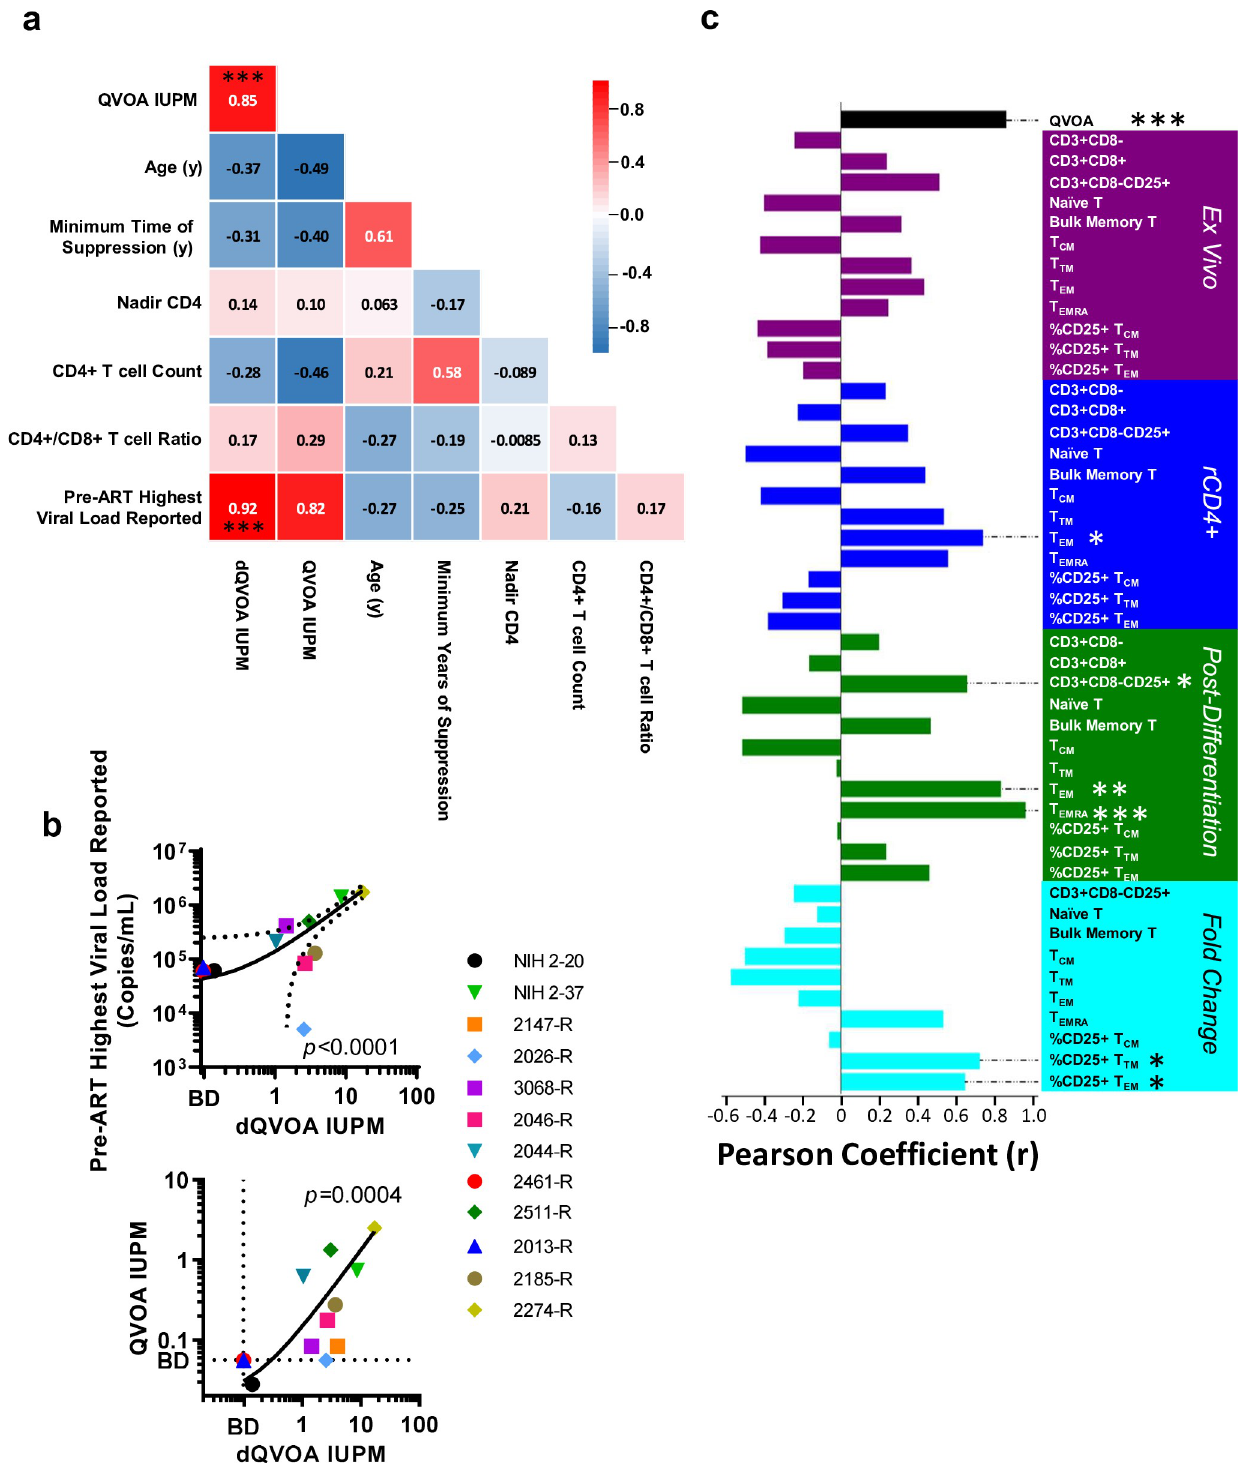
Fig 3. Reservoir measurements derived from dQVOA directly correlate with QVOA, pre-ART highest viral load reported, and effector memory T cells. a, The cross-correlation matrix (Pearson r value) of clinical measurements from linear regression. Analysis includes all available data from participants across the NIH and RAVEN cohort. ��� denotes p < 0.001. b, XY Graphical representation of correlations found to be significant in panel a . c , Correlation with dQVOA IUPM from linear regression (Pearson r value) for each individual measurement. Analysis includes available data from participants in the RAVEN cohort. � denotes p < 0.05; �� denotes p < 0.01; ��� denotes p < 0.001.